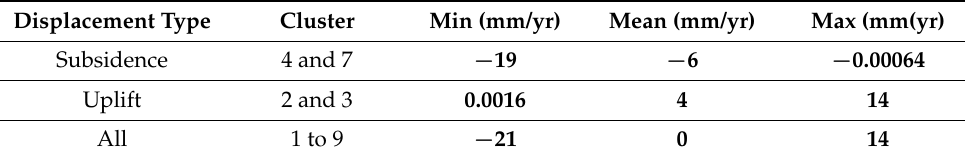
Figure 9. The SOM analysis in 9 clusters (Up: Uplift, Down: Subsidence). Table 4. Statistics about stable, subsidence, and uplift